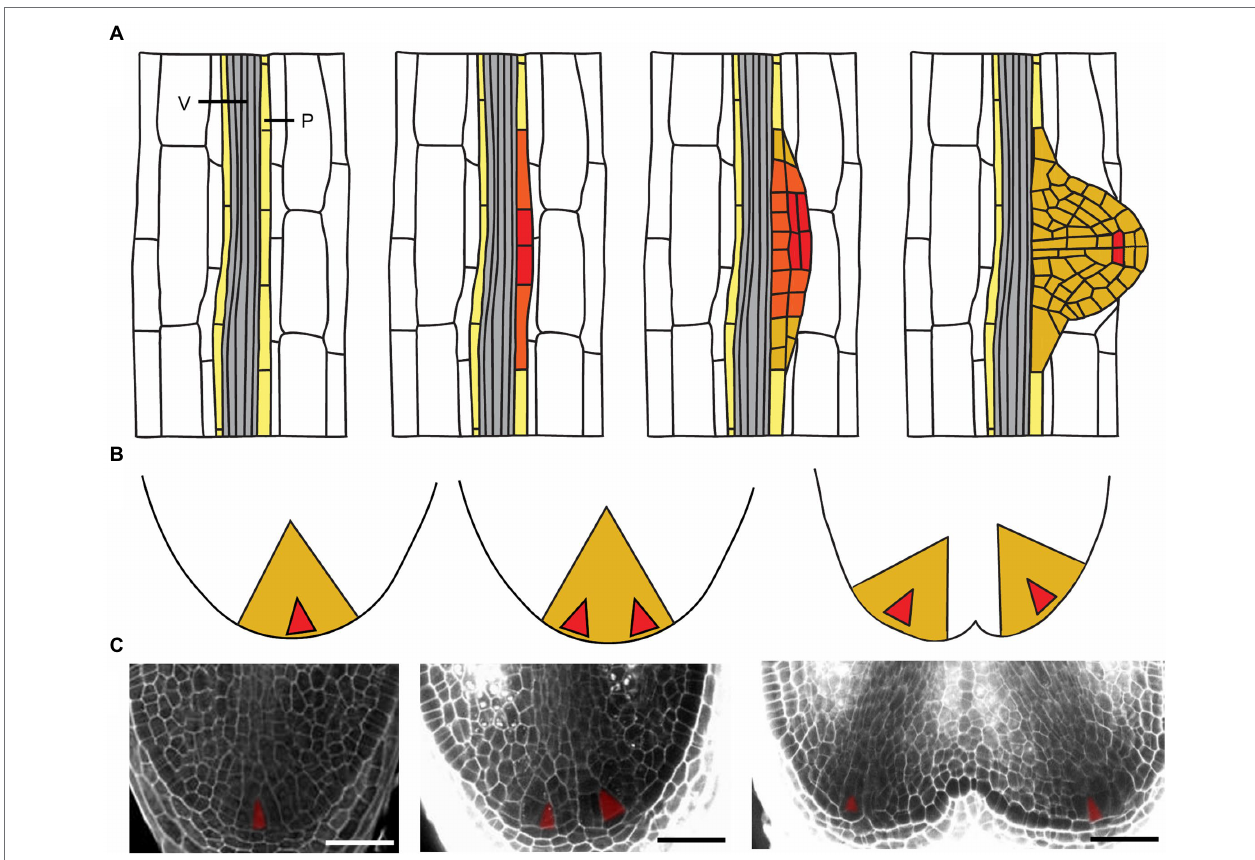
FIGURE 2 | Root branching processes in Arabidopsis and Selaginella. (A) Scheme of LR development in Arabidopsis. An LR initiates in the xylem-pole pericycle cells (P, light yellow). After a series of anticlinal and periclinal cell divisions, an LR primordium is developed. Gray indicates vascular tissue (V). (B,C) Scheme and images of dichotomous root branching in S. moellendorffii . Shortly after the meristem starts to bifurcate, two young root primordia are formed with apical cells installed. The meristems further develop into more mature primordia. The color gradient, red–orange–dark yellow, respectively, indicates high–medium–low levels of stem cell-ness in all the root meristems. Scale bars: 50 μ